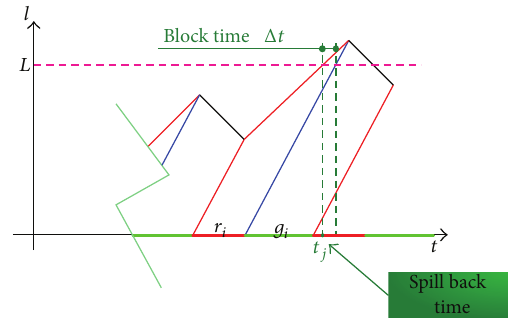
Figure 27: Spillover time and block